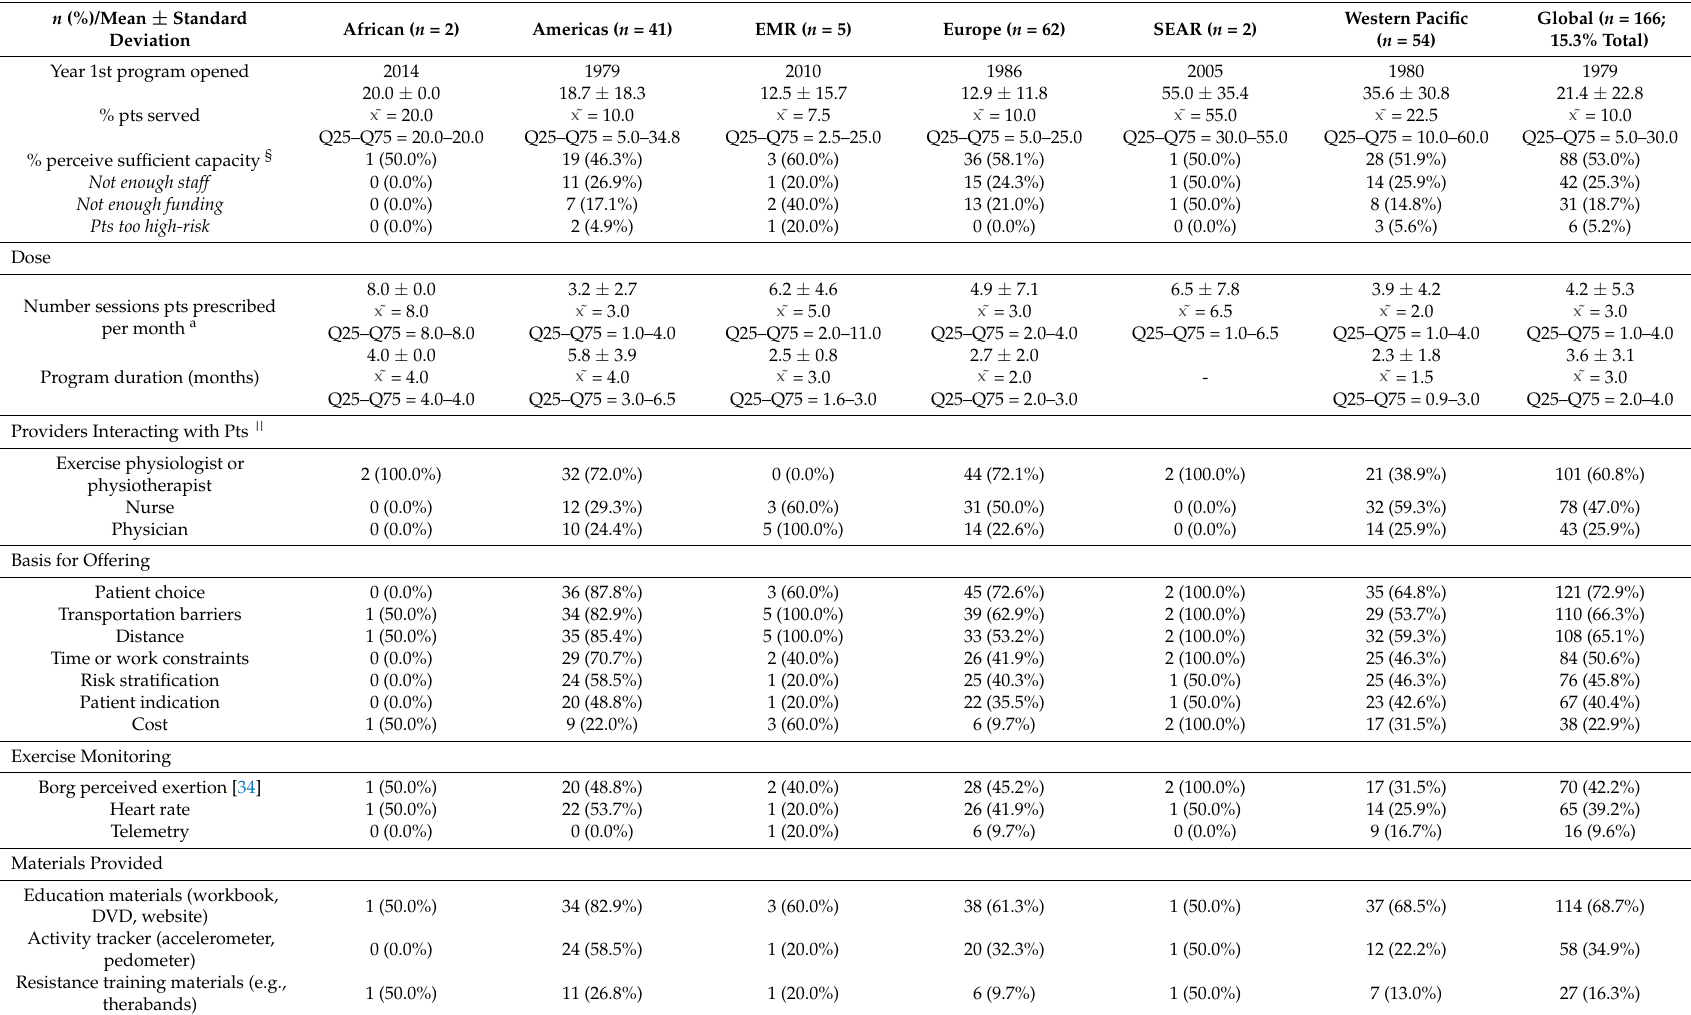
Table 1. Characteristics of Home-Based Programs by World Health Organization Region.